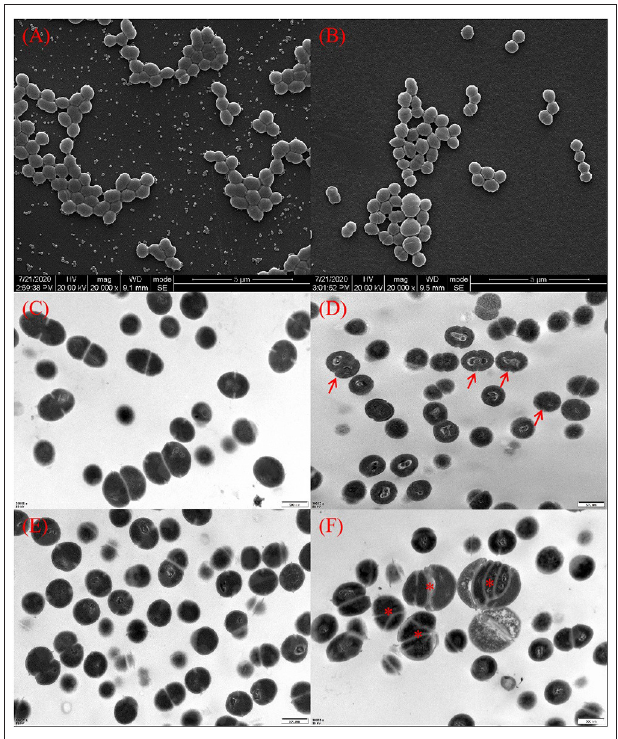
FIGURE 2 | Morphology of S. iniae cells treated with or without thymol under SEM and TEM. (A) Untreated S. iniae after 4h under SEM. (B) Thymol-treated S. iniae for 4h under SEM. (C) Untreated S. iniae cells after 8h under TEM. (D) Thymol-treated S. iniae for 8h under TEM. The arrows indicate rough and wrinkled cell surfaces. (E) Untreated S. iniae cells after 16h under TEM. (F) Thymol-treated S. iniae for 16h under TEM. The asterisks indicated abnormal enlargement and division of